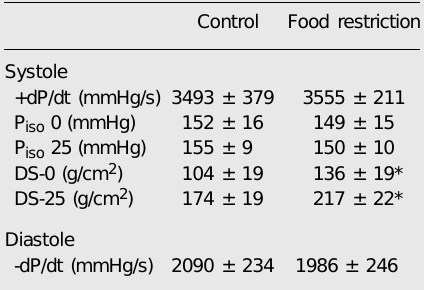
Diastole -dP/dt (mmHg/s) 2090 ± 234 1986 ± 246 Data are reported as means ± SD for 9 animals in each group. +dP/dt = rate of rise of ventricular pressure; P iso 0 and P iso 25 = developed pressure at diastolic pressure of zero and 25 mmHg, re- spectively; DS-0 and DS-25 = developed stress at diastolic pressure of zero and 25 mmHg, respec- tively; -dP/dt = rate of decrease of left ventricular pressure. *P < 0.05 vs control (Student t